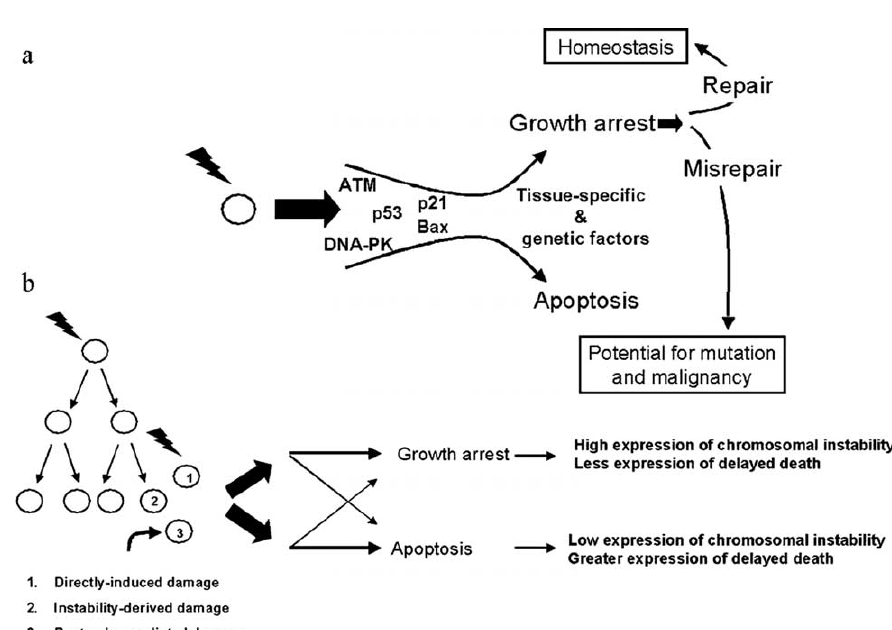
Fig. 3. (a) A schematic representation of how genetic modifiers influencing the p53 response pathway would reduce or reinforce the apoptotic response in a genotype-dependent manner. (b) The implications of genetic modification of responses in the p53 pathway for the expression of radiation-induced genomic instability and bystander effects in haemopoietic cells are shown schematically as a differential sectoring of response in genetic strains, susceptible to radiation-induced chromosomal instability and expressing low levels of delayed death and those relatively resistant to the expression of chromosomal instability expressing high levels of delayed